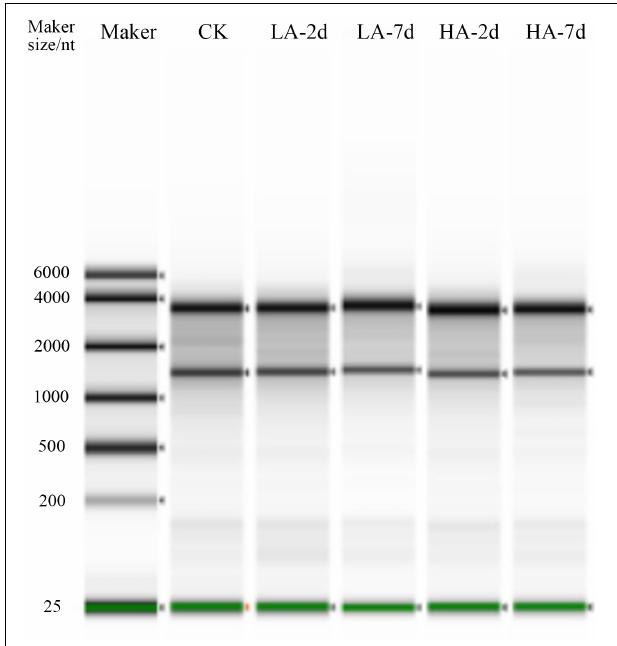
FIGURE 6 | Electrophoresis diagram of the Total RNA Automatic Nucleic Acid Electrophoresis